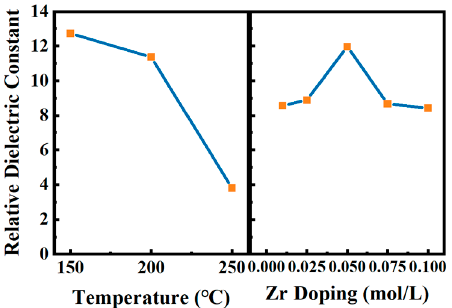
Figure 8. Main e ff ects plot of Zr–AlO x relative dielectric constant. Figure 8. Main effects plot of Zr–AlO x relative dielectric constant.